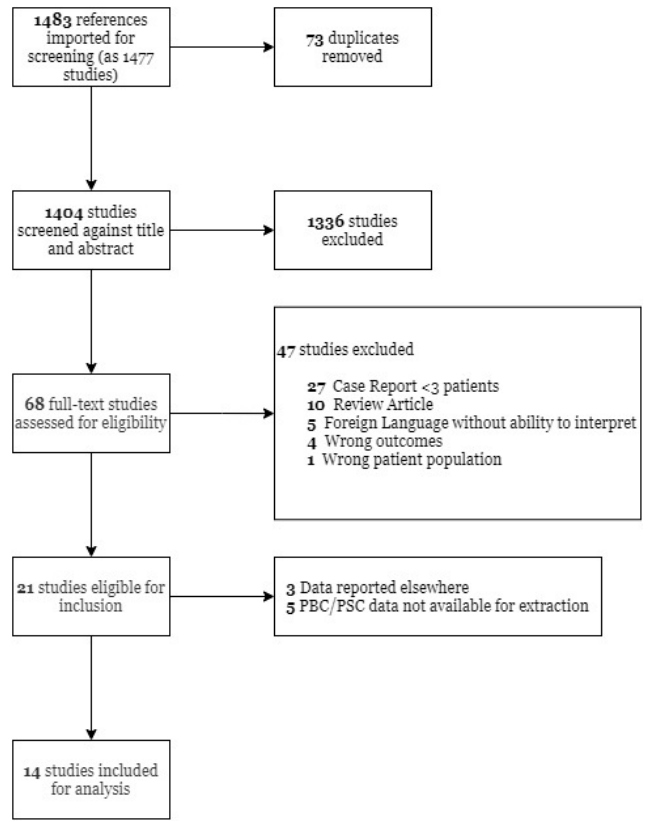
Figure 1. Flow diagram of the studies included in the systematic review and meta-analyses. PBC— Primary biliary cholangitis; PSC—Primary sclerosing cholangitis.